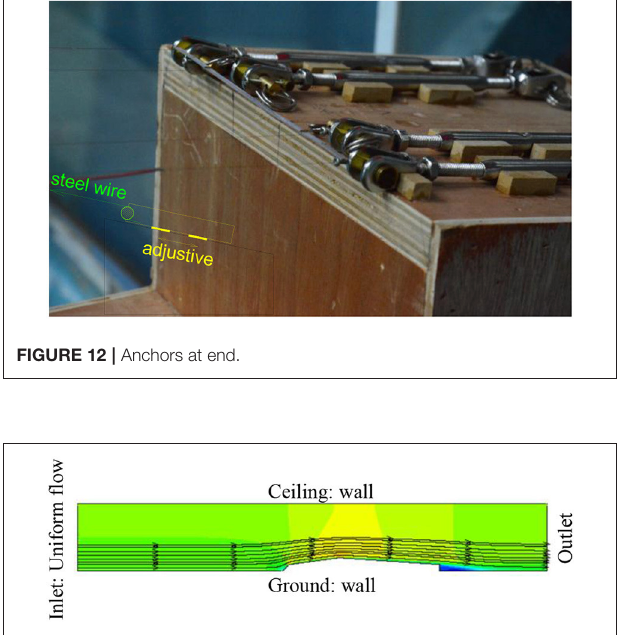
FIGURE 13 | CFD simulation of whole wind tunnel.